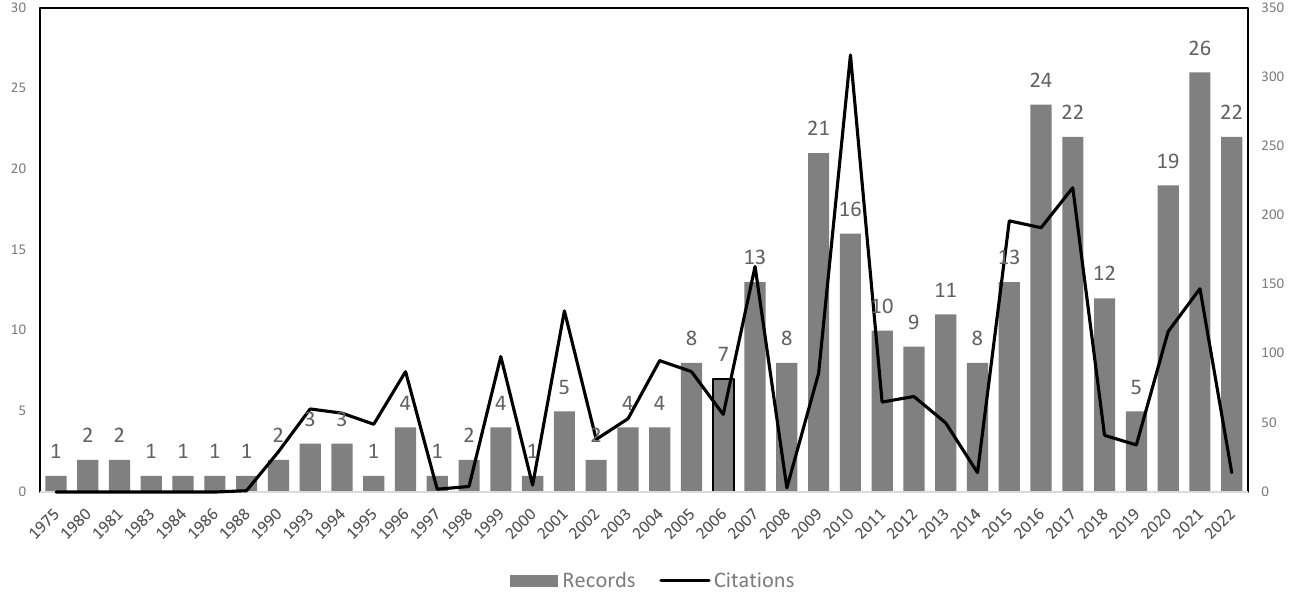
Figure 1. Trends in publication number and citations in construction bidding (1975–2020).